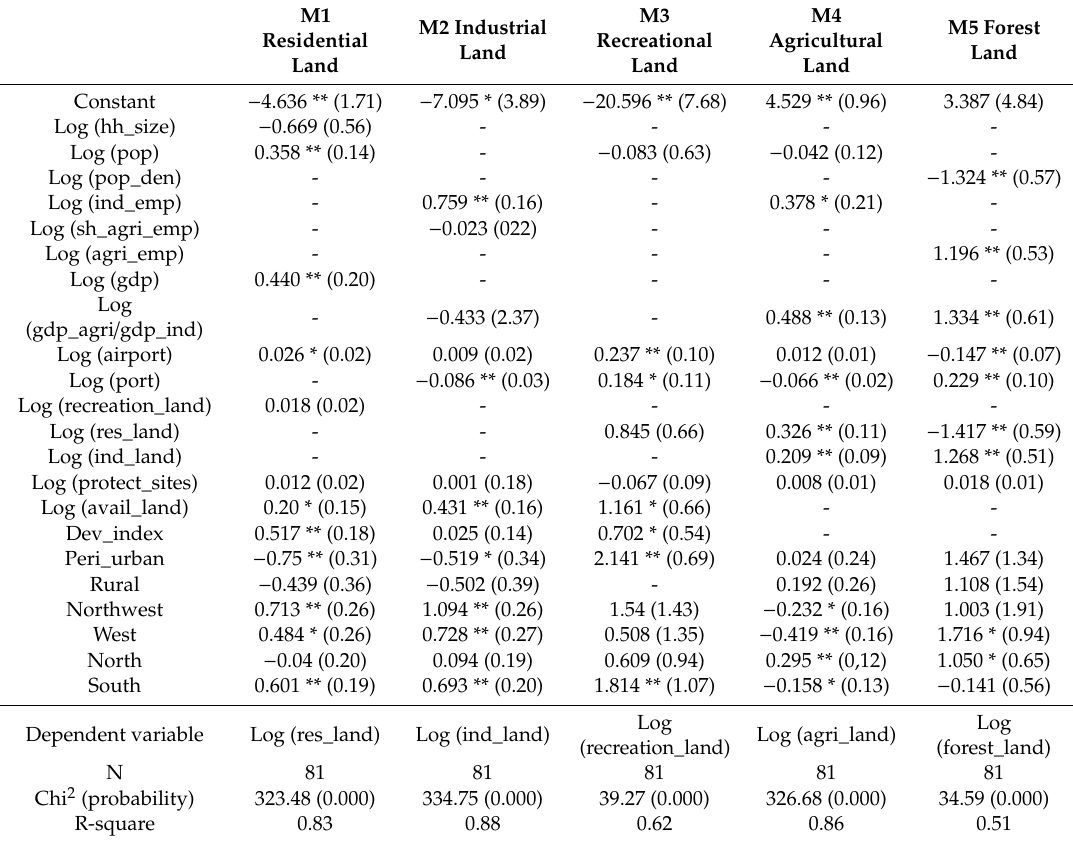
Table 7. Results of the seemingly unrelated regression (SUR) analysis explaining development of urban and non-urban